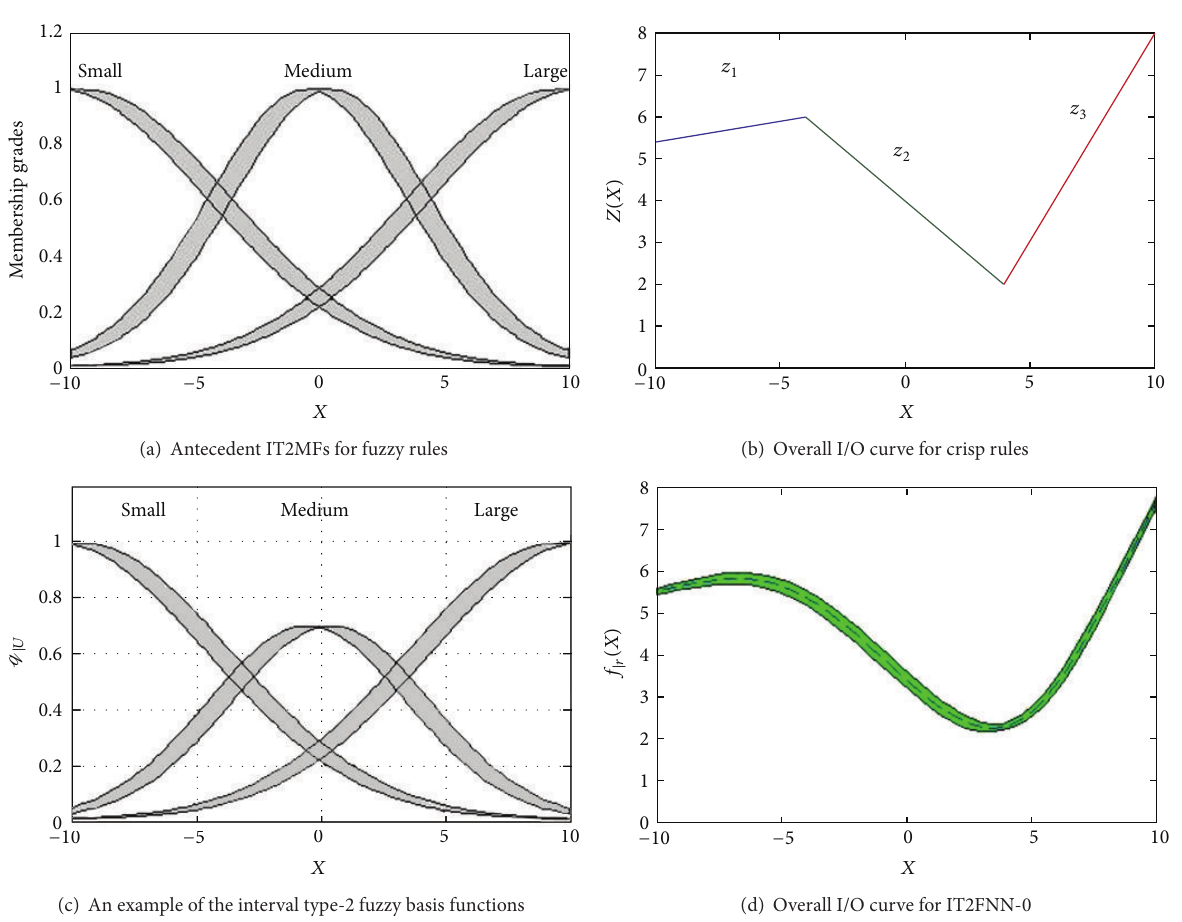
(d) Overall I/O curve for IT2FNN-0